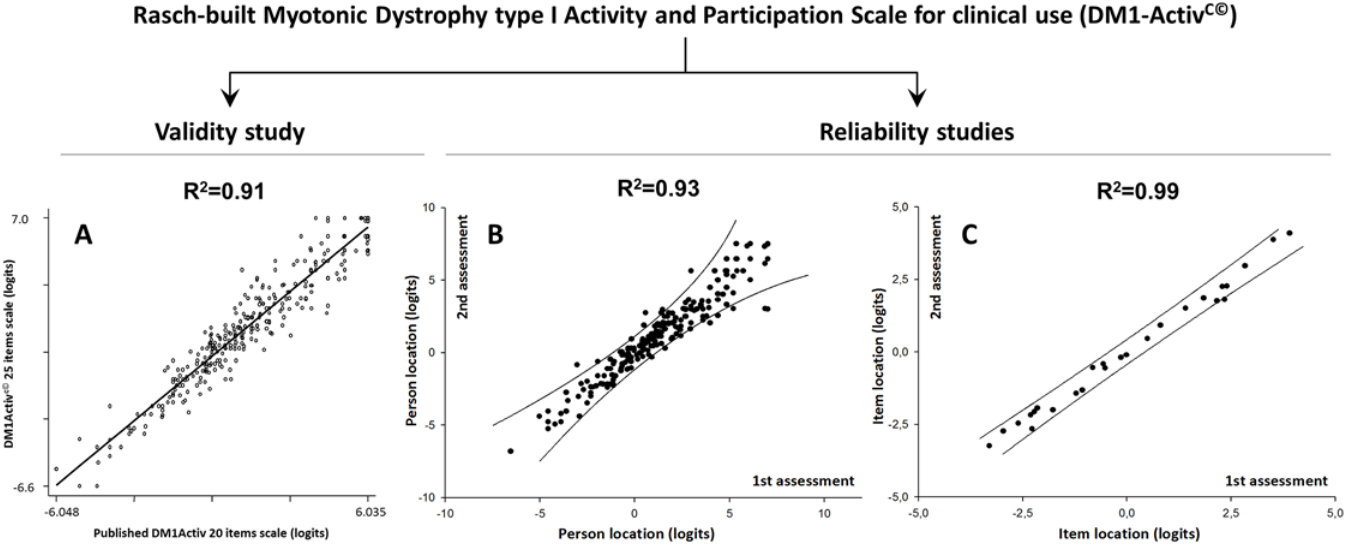
Fig 1. External construct convergent validity and test-retest reliability for DM1-Activ C . The 25-item DM1-Activ C scale demonstrates high external construct/convergent validity with the 20-items DM1-Activ (A). Patients ’ ability (B) and items ’ difficulty hierarchy (C) in the first and second assessment are located within the 95% confidence intervals indicating ideal invariance (solid